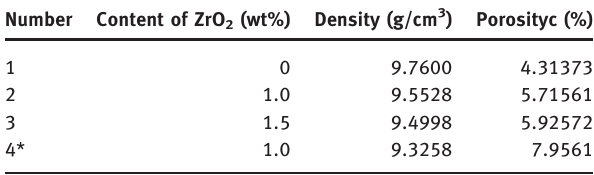
Table 1: The content of the additive in the alloys.